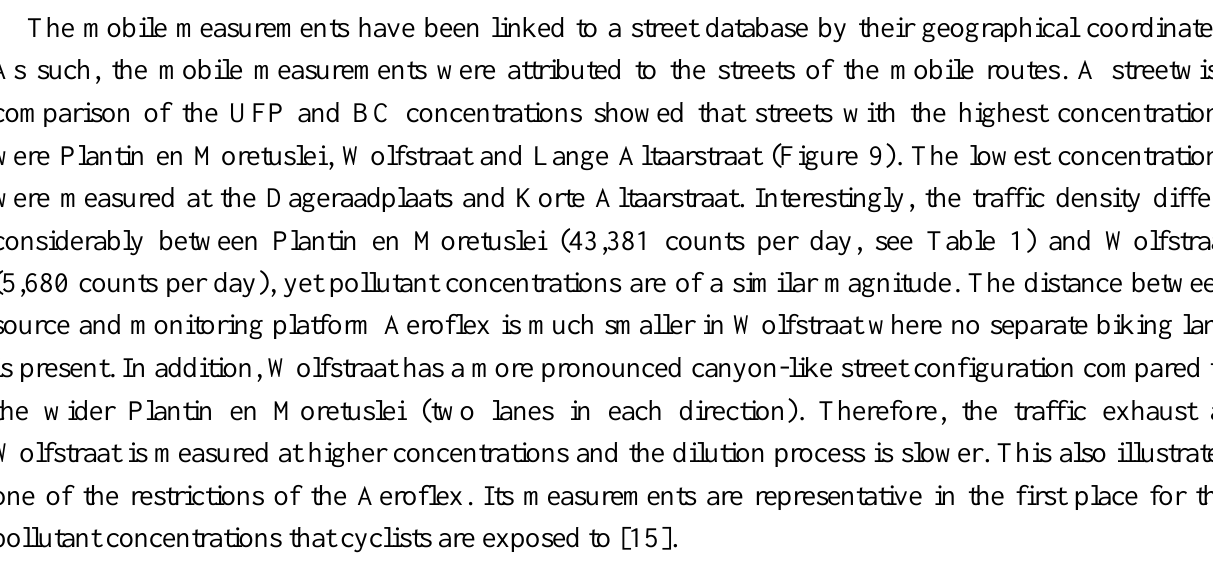
Figure 9. Boxplot of the UFP and BC concentrations for the streets of the monitoring route (merged data from the entire monitoring